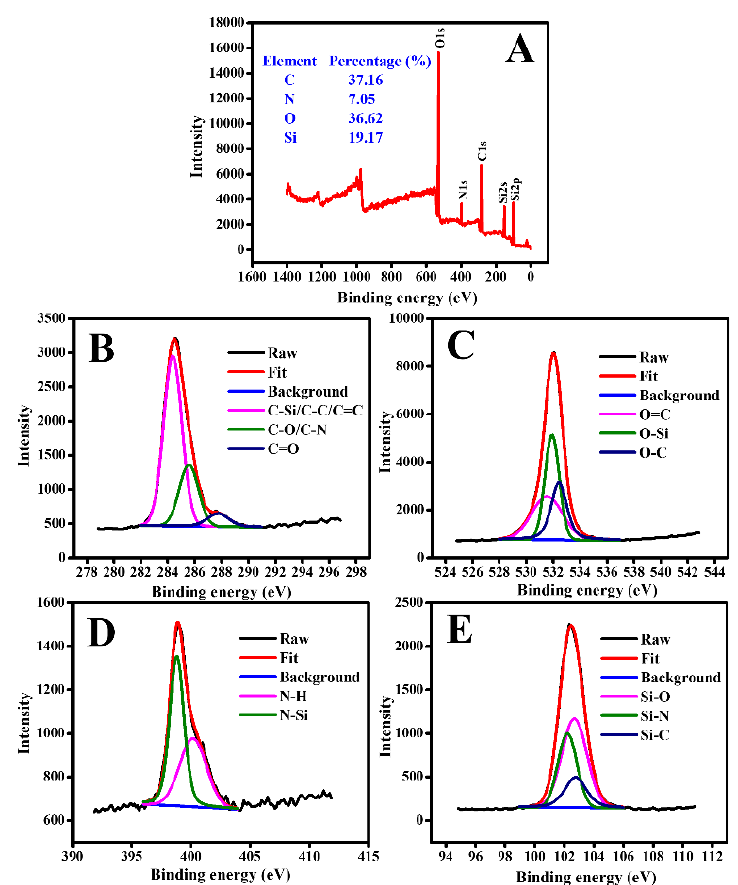
Figure 4. XPS profiles of GQDs@SMIP: survey spectrum ( A ) and high-resolution spectra of C1s ( B ), O1s ( C ), N1s ( D ), and Si2p ( E ).